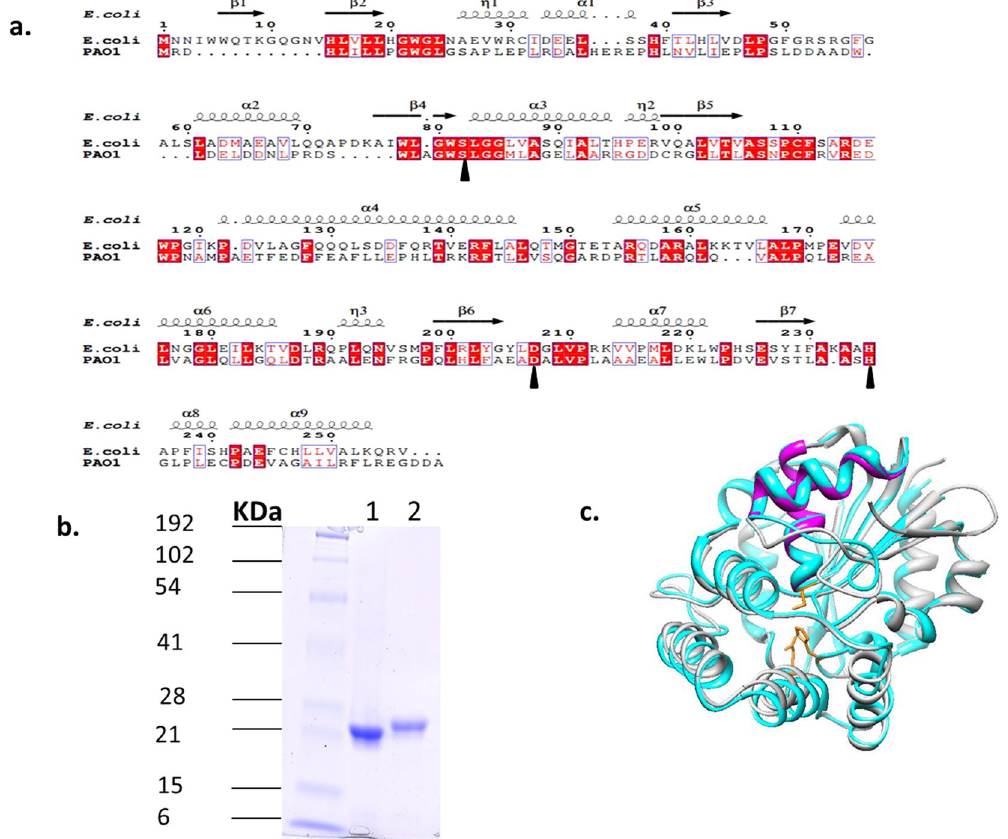
Figure 2. Sequence alignments, purification and modeling of BioH proteins. (A), sequence alignment of the BioH proteins of E. coli and P. aeruginosa PAO1. ( a) Conserved residues are shown as white letters on a red background, and similar residues are shown as red letters in blue boxes. The E. coli BioH secondary structure (Protein Data Bank ID 1m33) is shown at the top of the panel. The catalytic triad residues are denoted by black arrow heads. ( b) Purification of P. aeruginosa BioH (lane 1) and E. coli BioH (lane 2). The molecular masses of prestained broad-range protein standards (Bio-Rad) are indicated. The proteins were purified as described under Materials and Methods and analyzed by SDS-PAGE on a 15% polyacrylamide gel. ( c) Structural model of P. aeruginosa BioH (cyan) obtained by threading on the structure of E. coli BioH (grey) using the SwissModel website and PDB 1m33 17 . Helices 2 and 3 of the lid domain of E. coli BioH are coloured magenta. The side chains of the catalytic triad residues are coloured